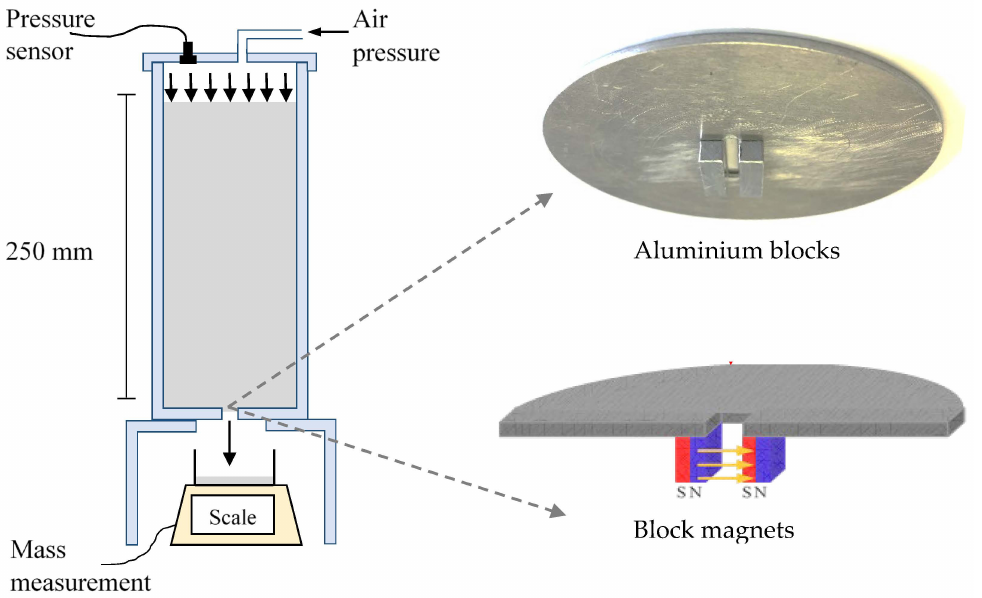
Figure 5. Test setup to study pressure-driven flow of cementitious paste